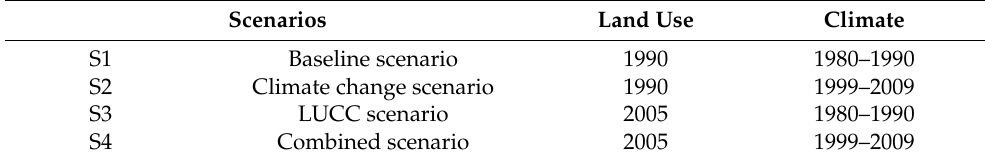
Table 3. The scenario setup for this